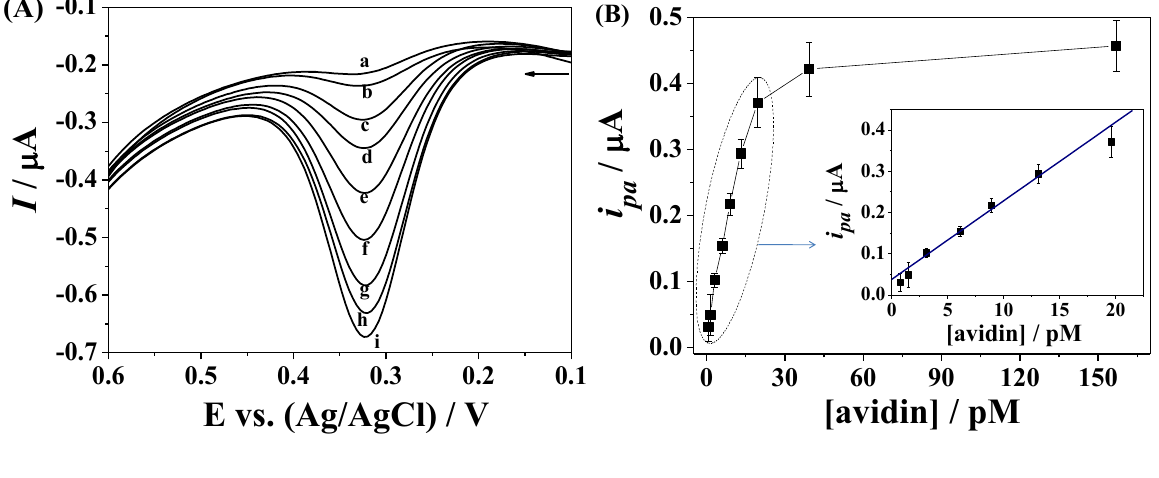
Figure 5. ( A ) DPVs of the sensing electrode at different concentrations of avidin (a–i: 0.75, 1.5, 3.1, 6.2, 8.9, 13.1, 19.6, 39.3 and 157 pM); ( B ) plots of the i avidin concentration (0.75–19.6